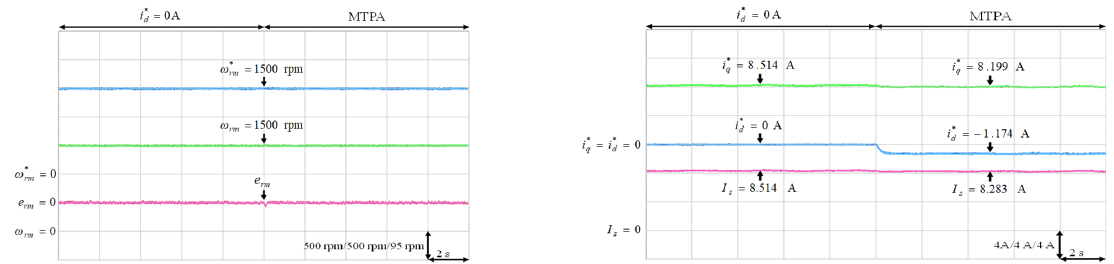
Figure 13. Experimental results of MTPA control at 1500 rpm with 6 Nm: ( a ) mechanical speed command, speed and speed error; ( b ) q -axis current command, d -axis current command and stator